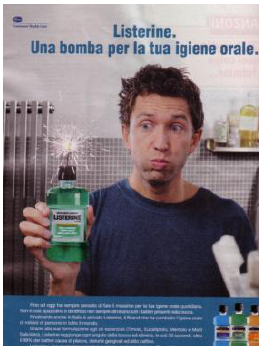
Figure A14. Own selected picture, ridiculous